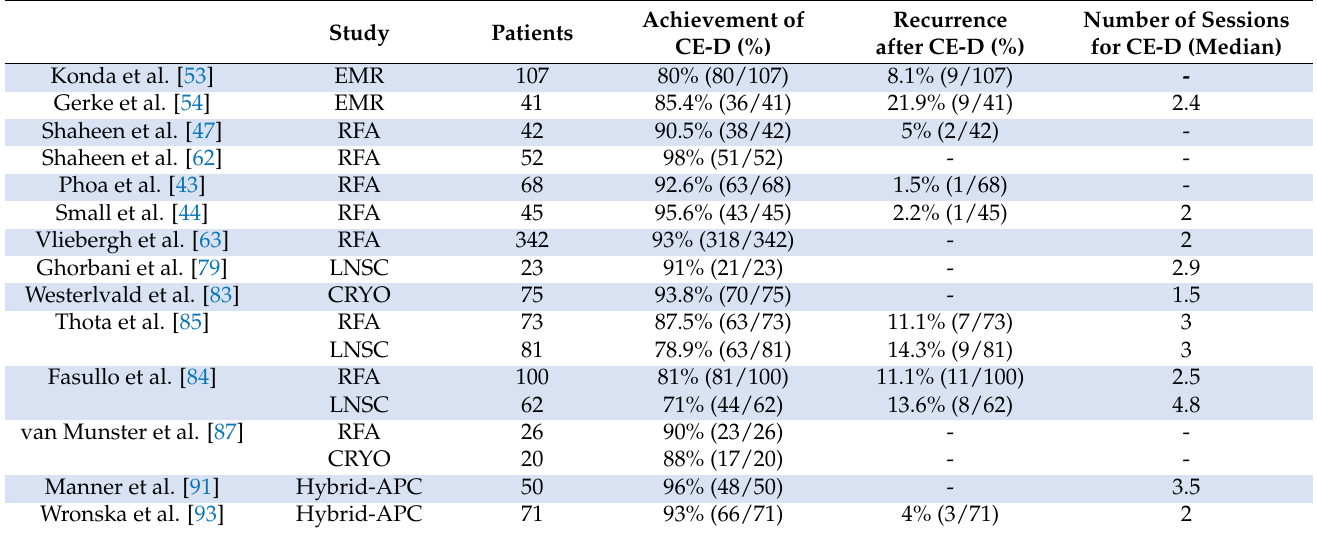
Table 3. Characteristics of studies comparing the different techniques for LGD BE-related